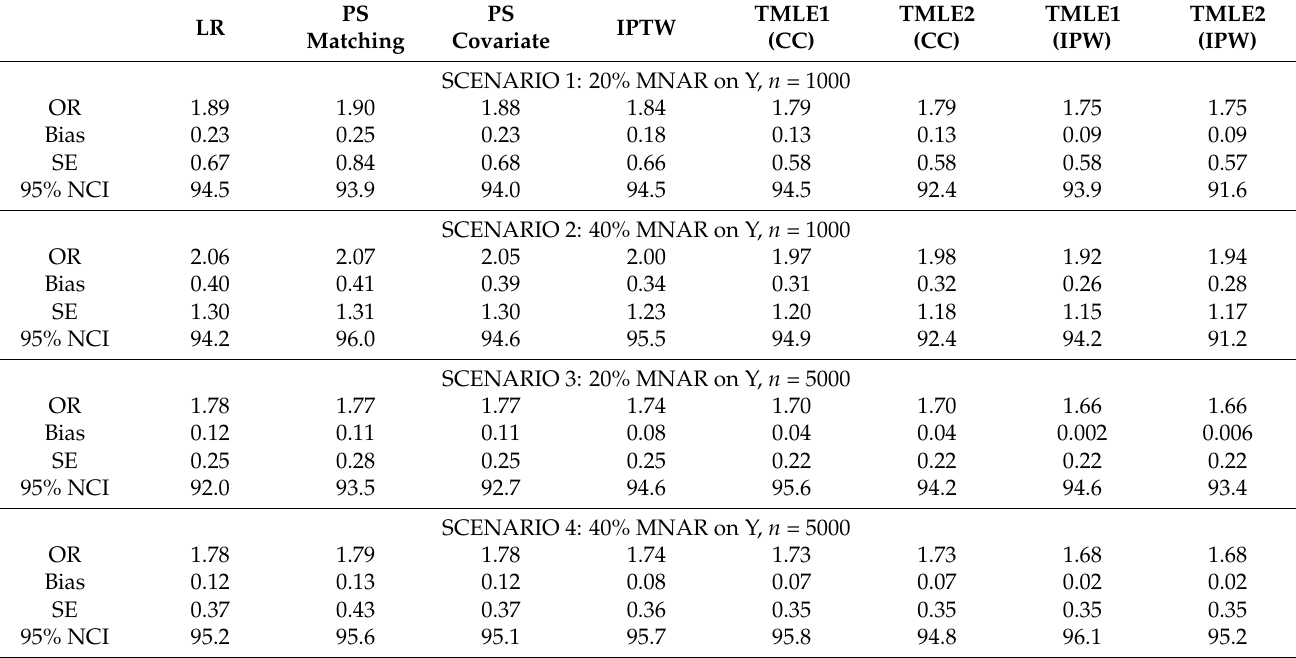
Table 3. The results of the simulation study with different scenarios and the MNAR mechanism on the